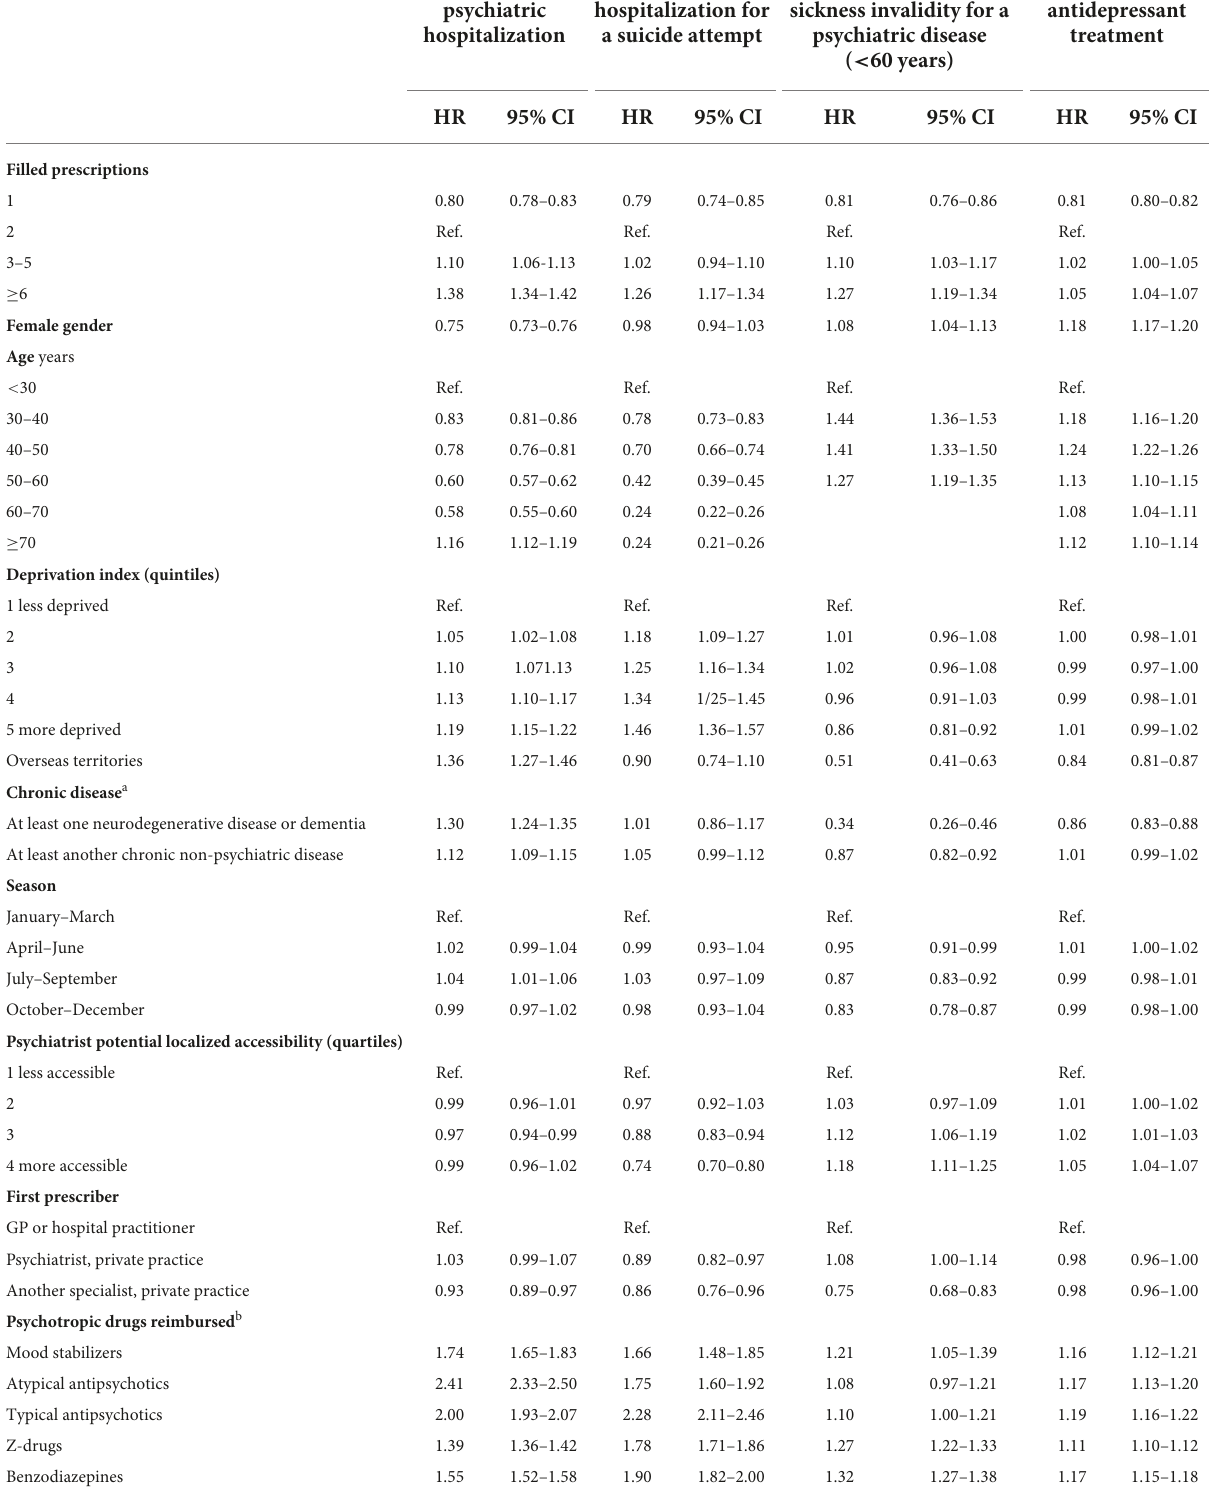
TABLE 3 Hazard ratios for each long-term psychiatric outcome according to the number of filled antidepressant